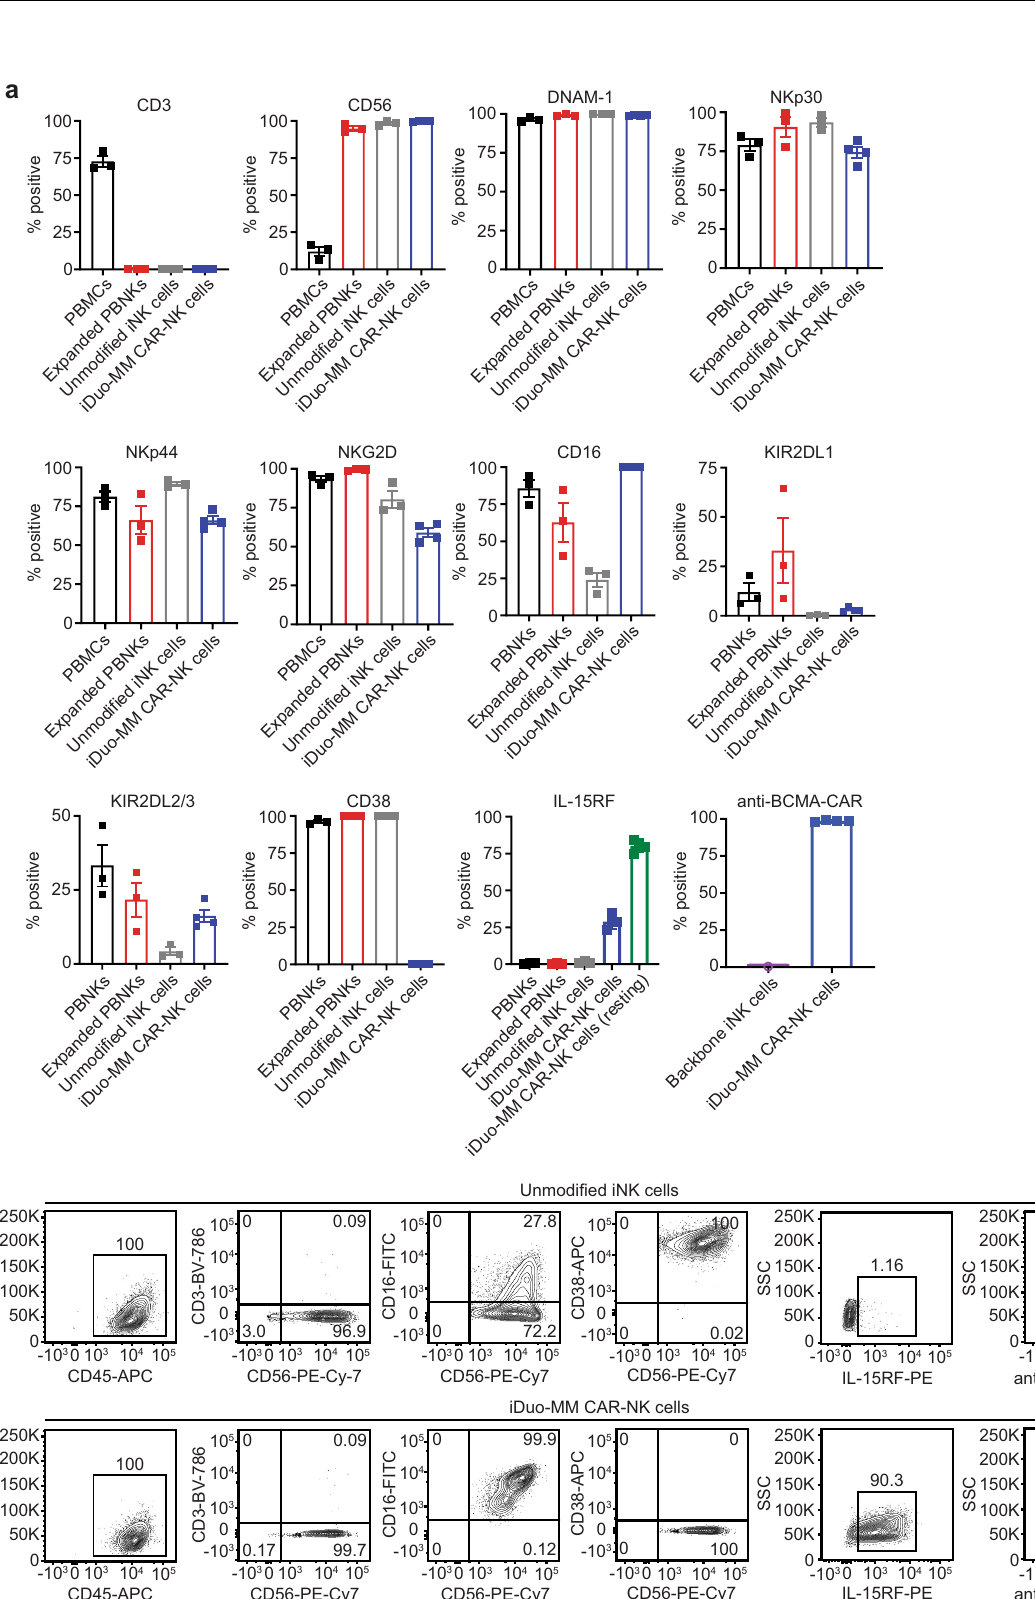
anti-BCMA CAR levels. Data are presented as mean values ±SD. b Flow cytometry analysis of CD56 and cell-surface anti-BCMA CAR levels on iNK cells differentiated from an iPSC clone with backbone edits only, an iPSC clone with backbone edits, and the anti-BCMA-CAR4 construct (iDuo-MM CAR-NK